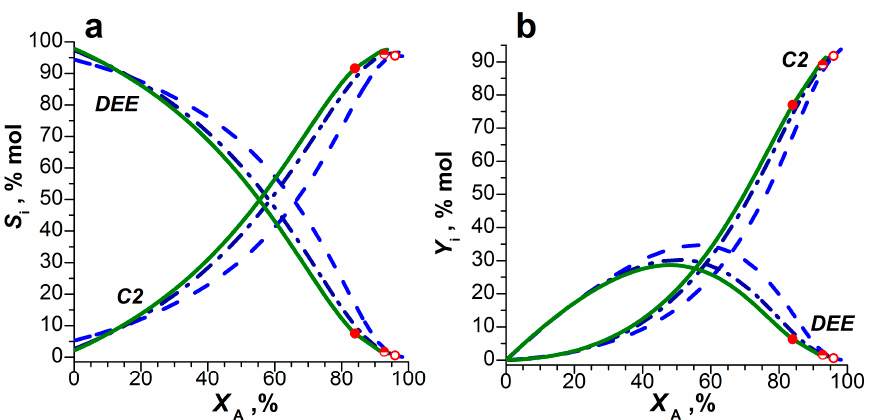
Figure 4. The calculated C2 and DEE selectivity ( a ) and yield ( b ) vs. ethanol conversion X A in PFR . Conditions: 400 ◦ C, 1.2 g catalyst, 21.05 g/h solution of 92% wt EtOH and C3-alcohol impurities of 0.001 (dash, open), 0.15 (dash-dot, half), and 0.3% mol (solid, solid). Symbols indicate S i and Y i at LHSV A ≈ 27 h –1 .